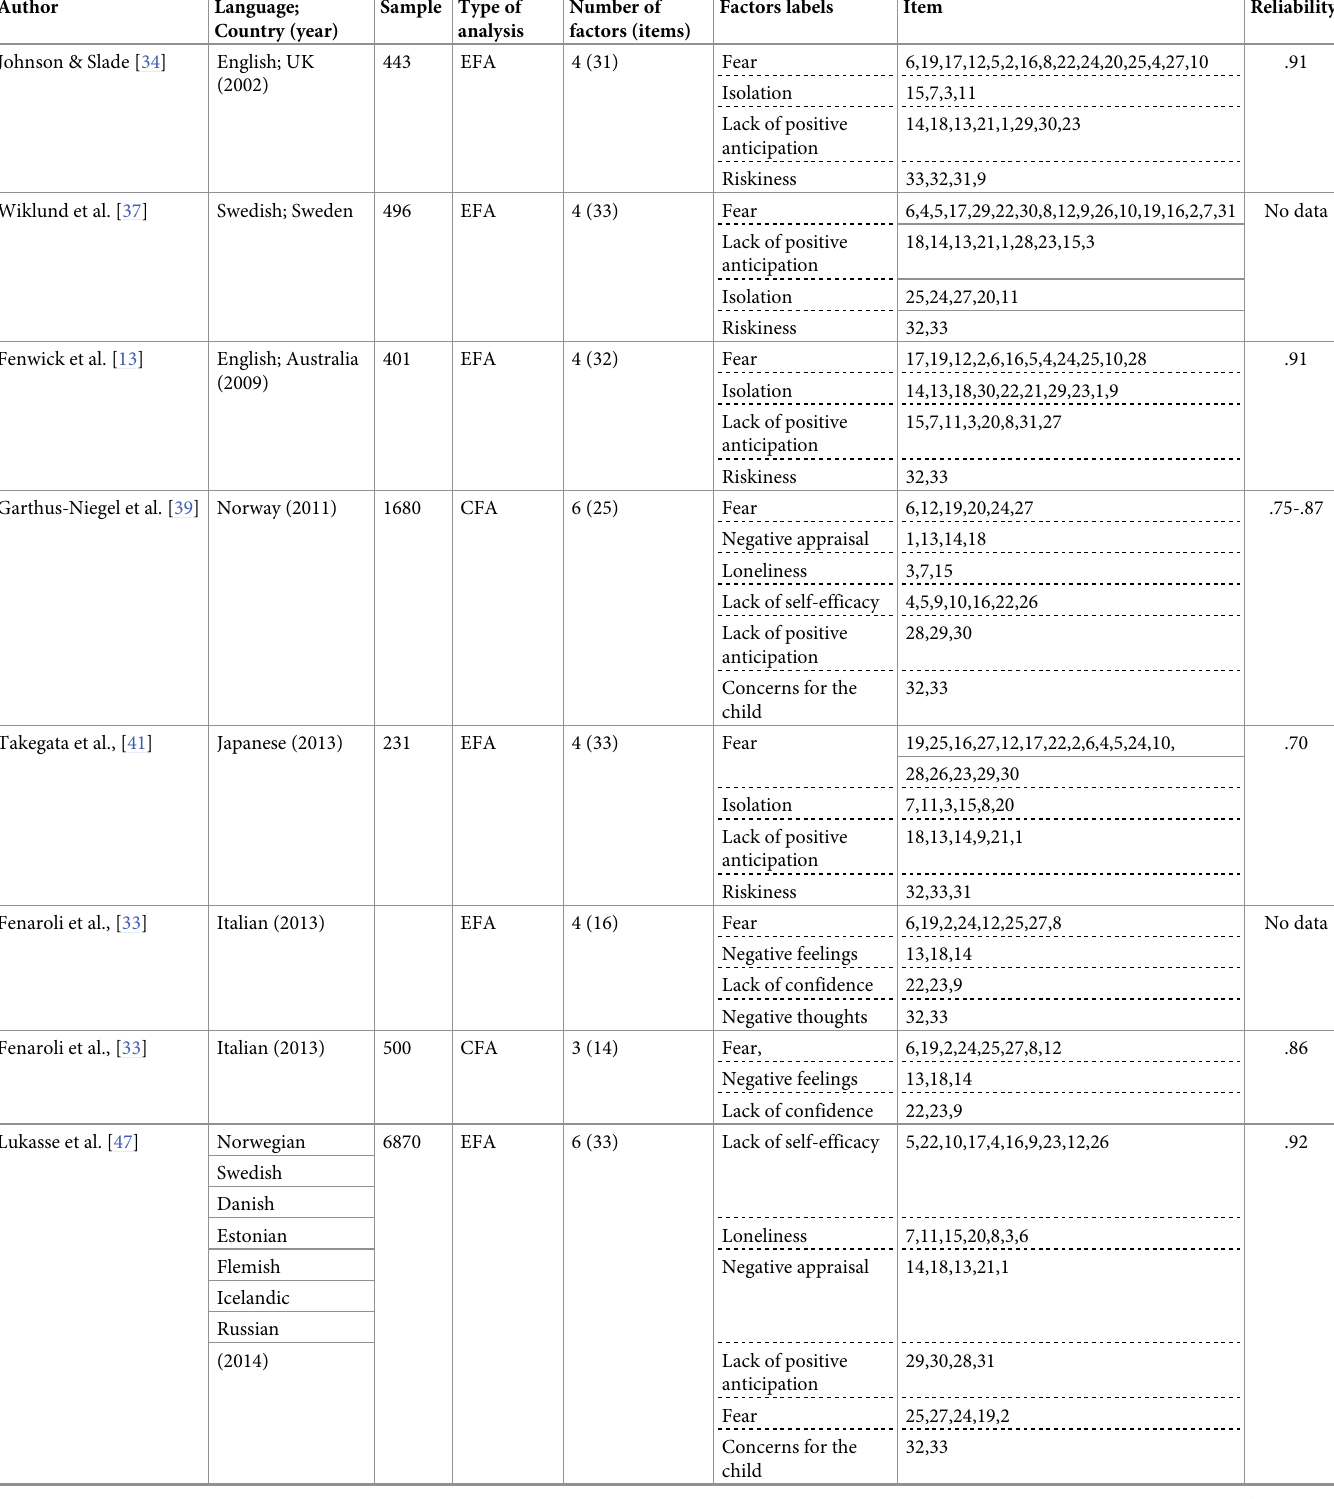
Table 1. Summary of the characteristics of the WDEQ validated in the different languages and